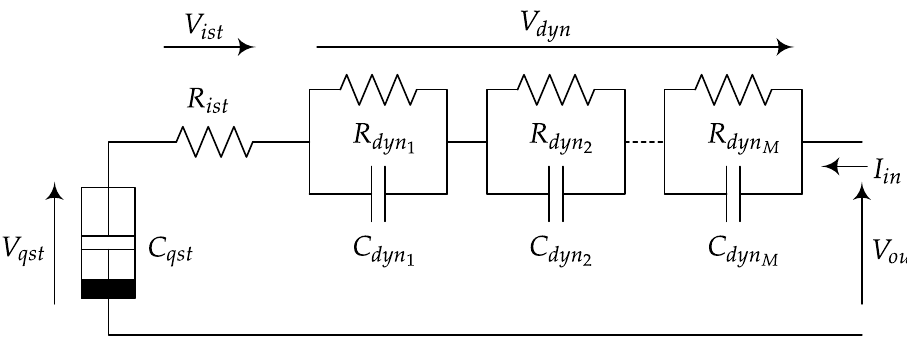
Figure 4. Circuit diagram of the (quasi) linear ECM for a battery cell SoC estimation.